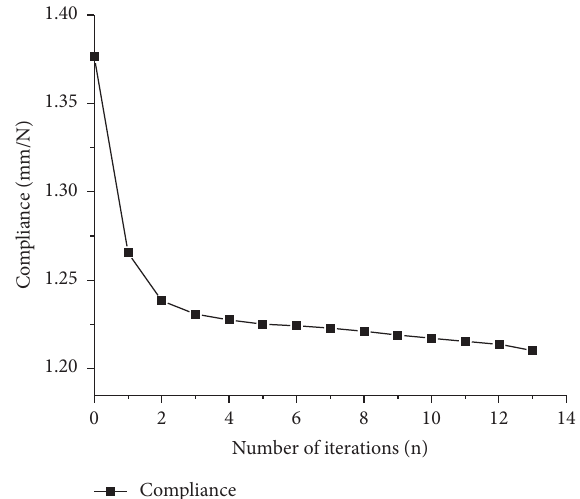
Figure 6: Schematic of the compliance iteration process.